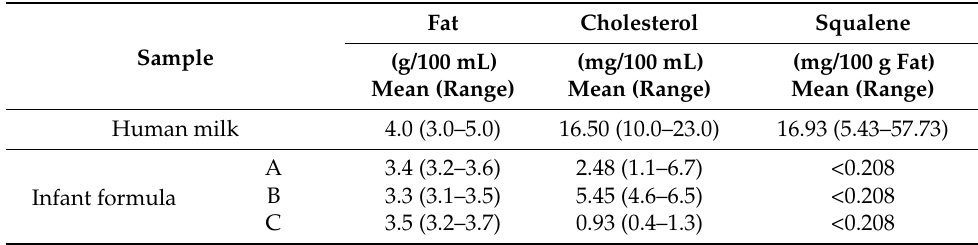
Table 2. Average content of fat, cholesterol, and squalene in human milk and formula milk of se- lected producers.